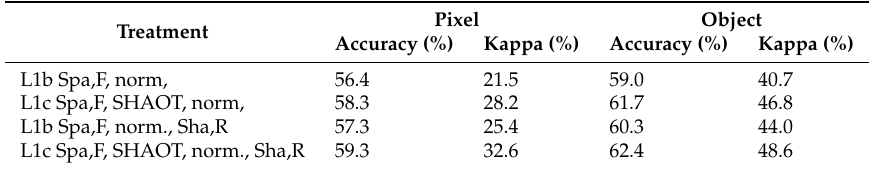
Table A2. Summary of mean accuracies and kappa results from data acquired on the 19 September using the 20 most abundant species based on a Random Forest